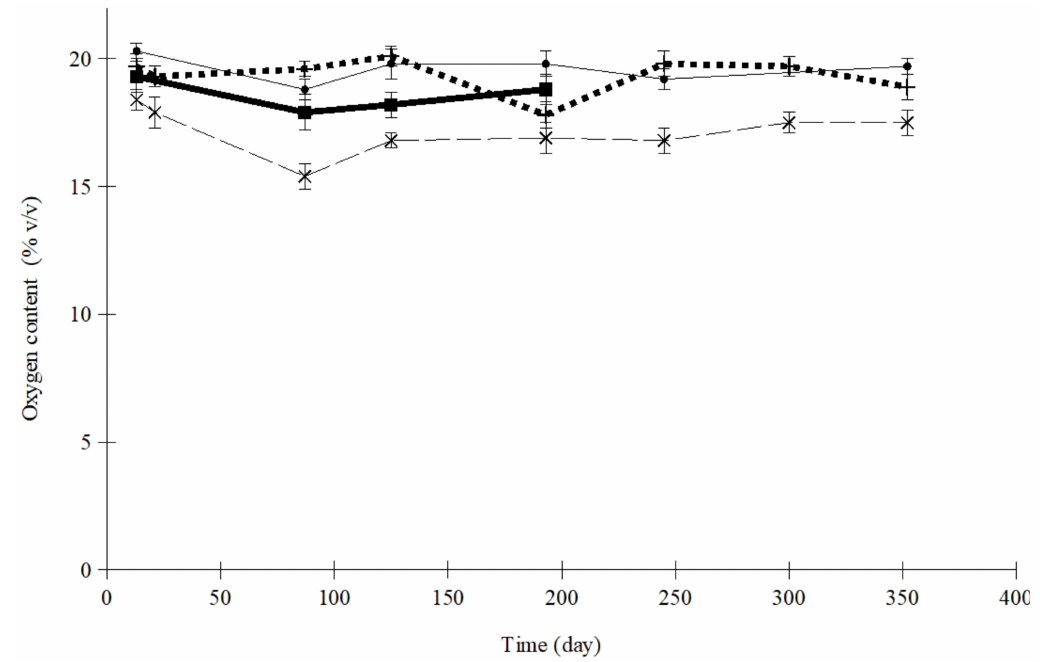
Figure 3. O 2 concentration in trays containing dried apricots sealed with air (OPA/PE: +, 5 ◦ C; × ,